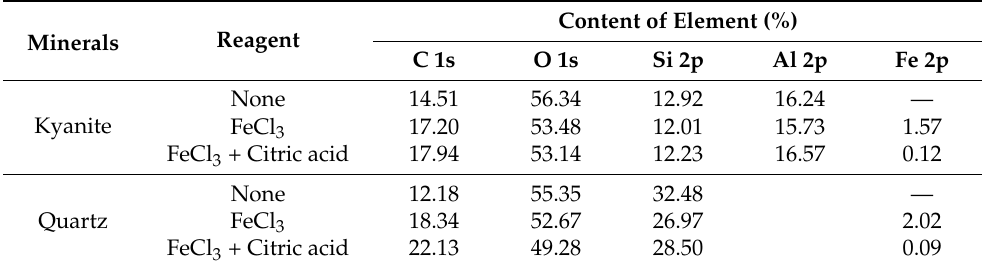
Figure 8. Binding energy of quartz with and without regulator treatment.